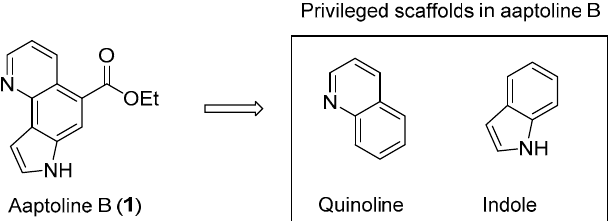
Figure 1. Proposed structure of pyrroloquinoline alkaloid aaptoline B ( 1 ) and embedded privi- leged scaffolds.